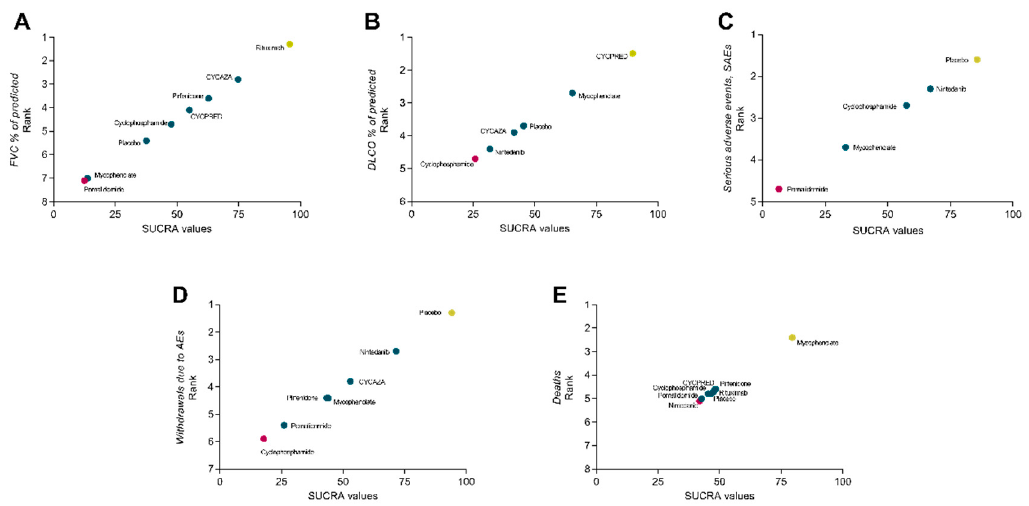
Figure 4. Surface under the cumulative ranking curves (SUCRAs) vs. rank. ( A ), change in forced vital capacity % of predicted (FVC %); ( B ), change in diffusion lung capacity for CO % of predicted (DLCO %); ( C ), number of patients with serious adverse events (SAEs); ( D ), number of patients discontinuing treatment for adverse events (AEs); ( E ), deaths. Treatments have been ranked according to SUCRAs. For example, in ( A ), rituximab is the treatment with the highest probability of being the best (RANK 1) having the highest SUCRA (95.7). ( C – E ), treatment with the best rank are those with better tolerability, safety, and lower number of deaths,